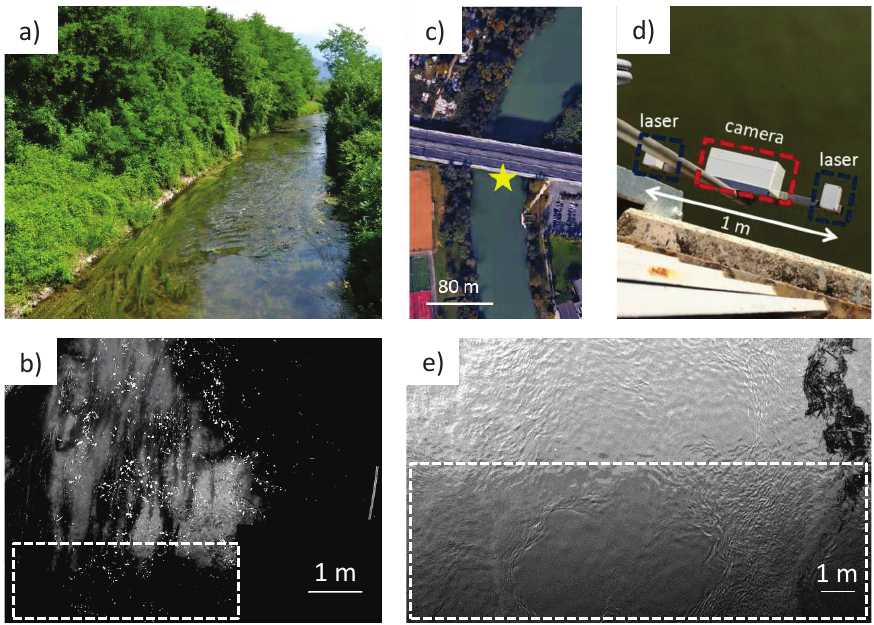
Figure 1. ( a ) View and ( b ) representative processed image of the Brenta River; ( c ) location of the gauge-cam on the Tiber River; ( d ) camera and laser units of the gauge-cam, and ( e ) representative processed image. The white dashed rectangles in panels ( b , e ) indicate regions at darker intensity due to the bridge